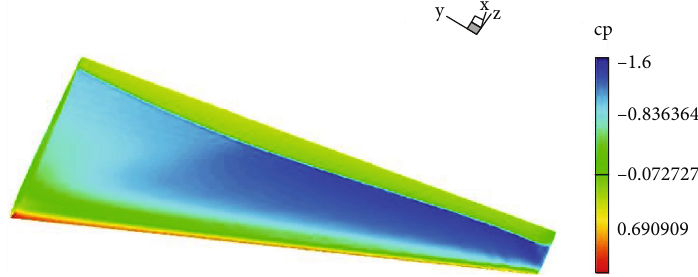
Figure 6: The pressure coe ffi cient (Cp) distribution map of upper surface.